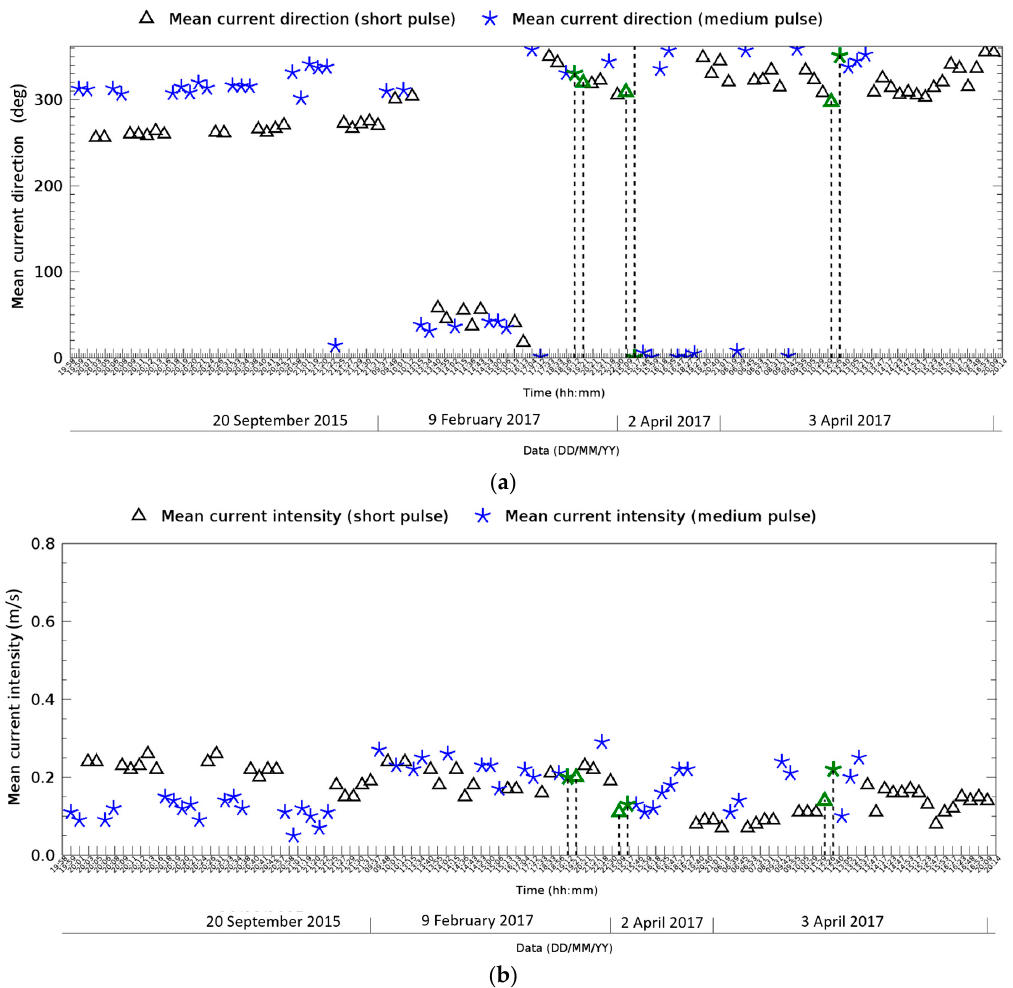
Figure 6. Mean current intensity ( a ) and Mean current direction ( b ) obtained by analyzing radar data in medium (blue star) and short (black triangle) pulse mode configurations. The green symbols and the vertical dashed lines indicate the measurements values obtained from the surface current maps used for the qualitative comparison in Figure 5.